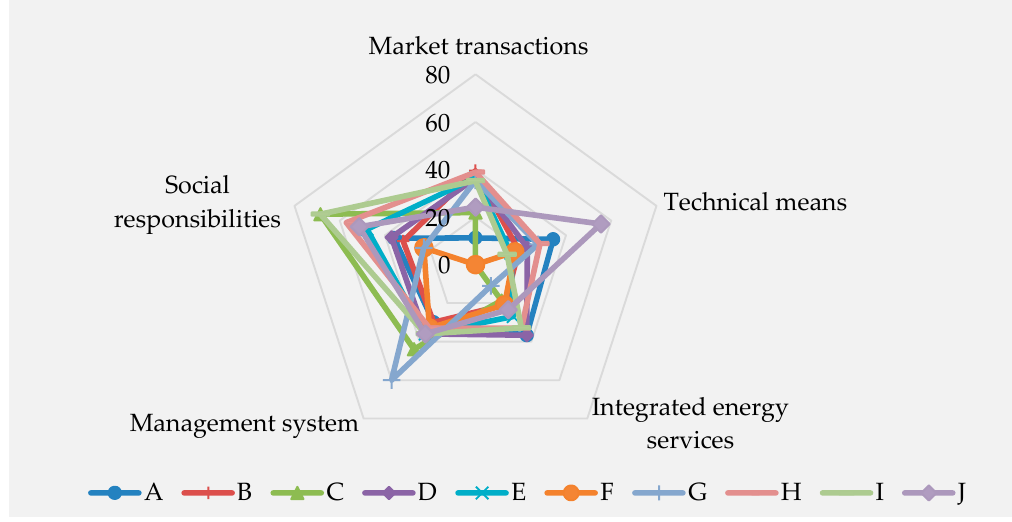
Figure 5. Radar chart of energy saving and emission reduction effects of the five electricity retailers.